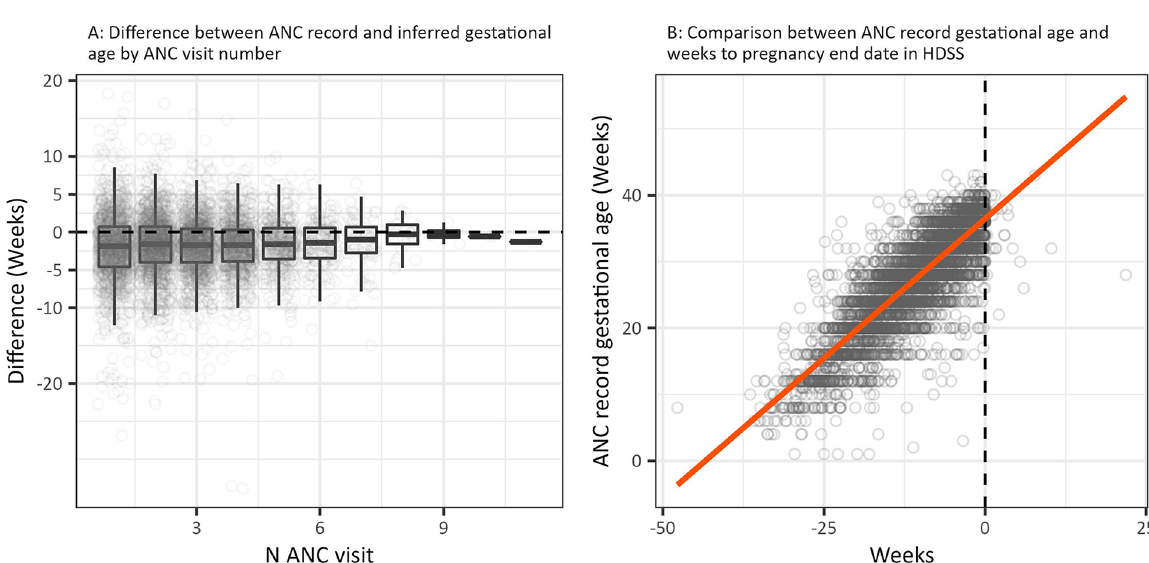
Figure 4: Comparison of gestational age fromantenatal care (ANC) register and gestational age inferred from the pregnancy end date in the Health and Demographic Surveillance System